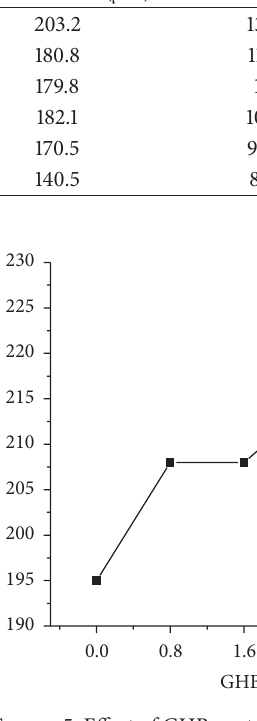
Figure 5: Effect of GHB content on the slump flow of